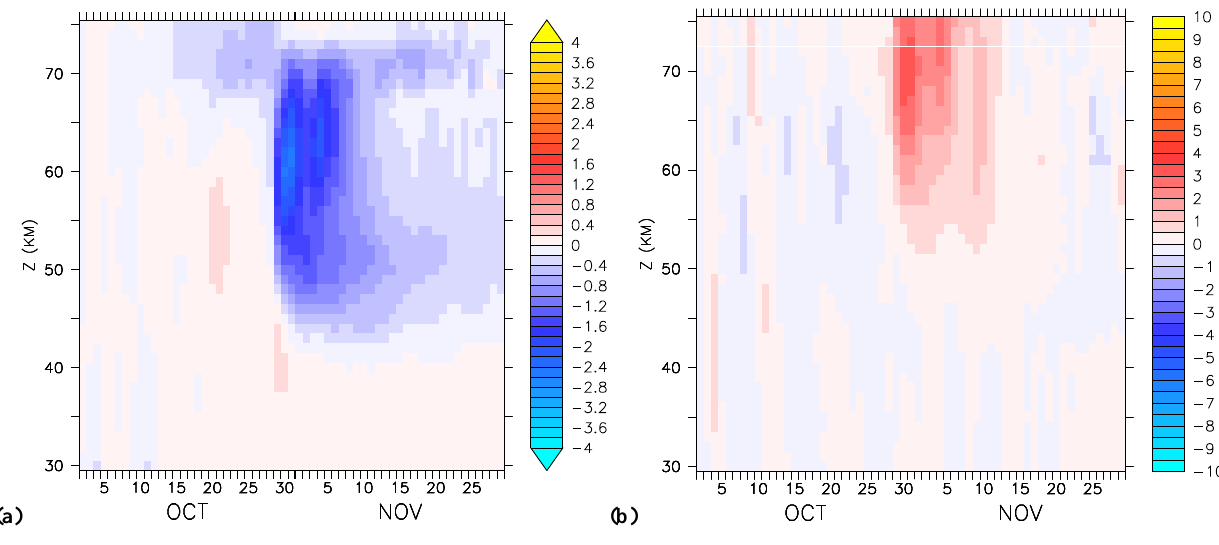
Fig. 18. (a) Change of temperature (K) between two free running simulations with and without SPE submodel turned on. (b) Change of zonal mean wind